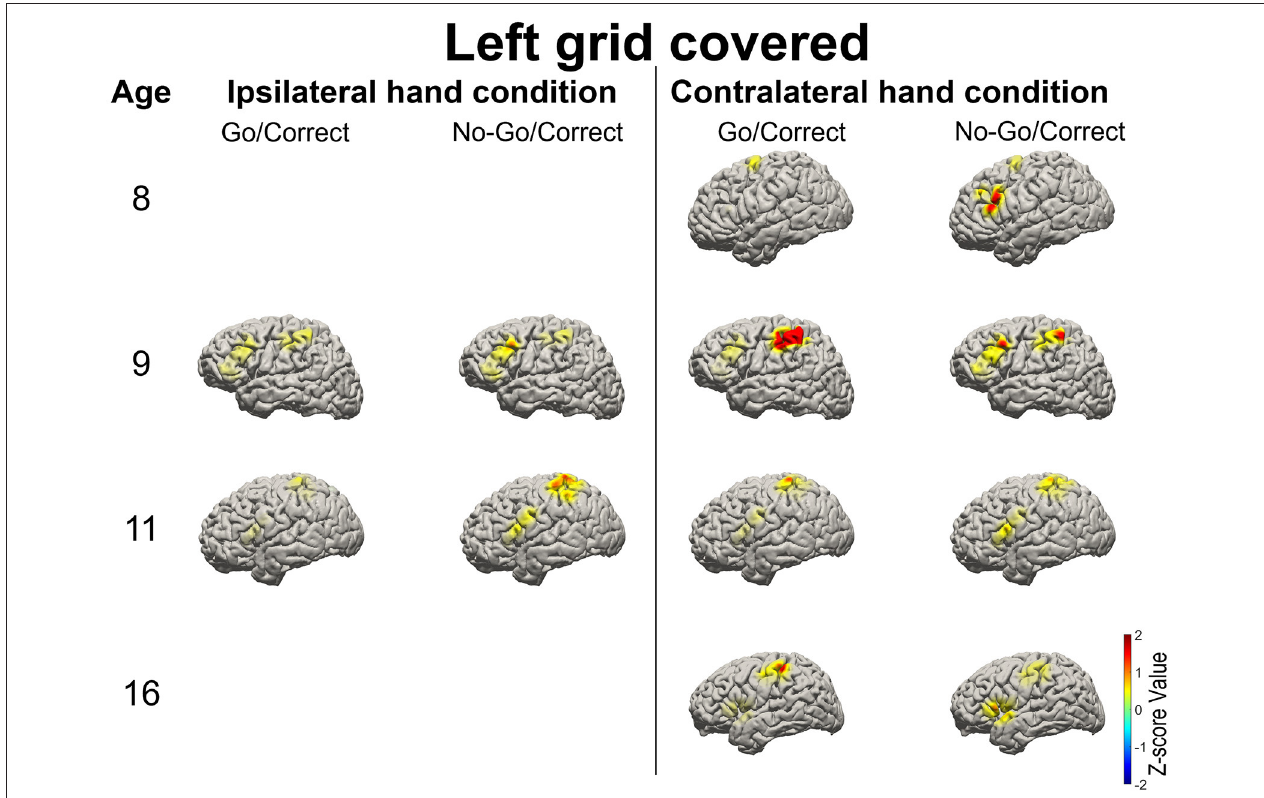
FIGURE 4 | Illustration of the mean high-gamma (HG) activation for the patients aged 8, 9, 11, and 16 years with left-side grid coverage. Activation of the left IFG in No-Go/Correct trials is higher than that in Go/Correct trials. HG activation over the sensorimotor cortex was observed in Go/Correct trials when the contralateral hand was used (in this case the right